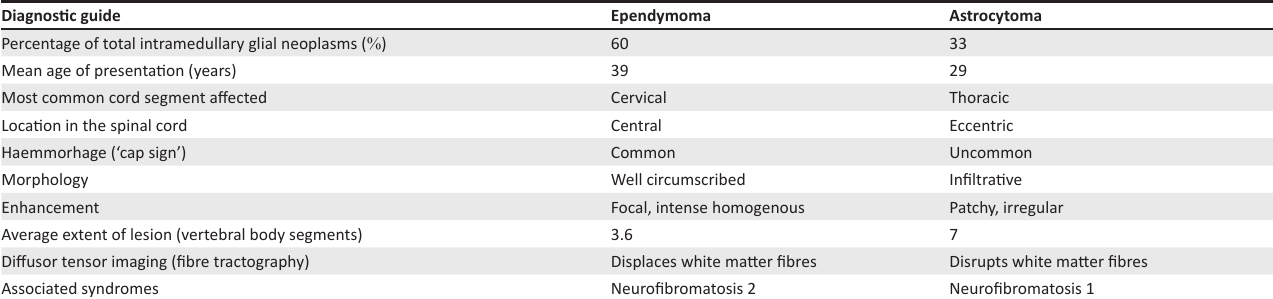
FIGURE 4: Intramedullary ependymoma of the spinal cord. Sagittal T2-weighted image (a) demonstrates a bulky mass (white arrow) expanding the spinal cord at the level of T1–T3 with oedema (yellow arrows) and patchy enhancement (blue arrow in [b]) on the contrast-enhanced sagittal T1-weighted image; (b) Fibre tractography clearly shows displacement of the fibre tracts concentrically outward at the level of the tumour; (c) suggesting an ependymoma arising from the ependymal cells of the central TABLE 2: Spinal cord ependymoma vs astrocytoma.